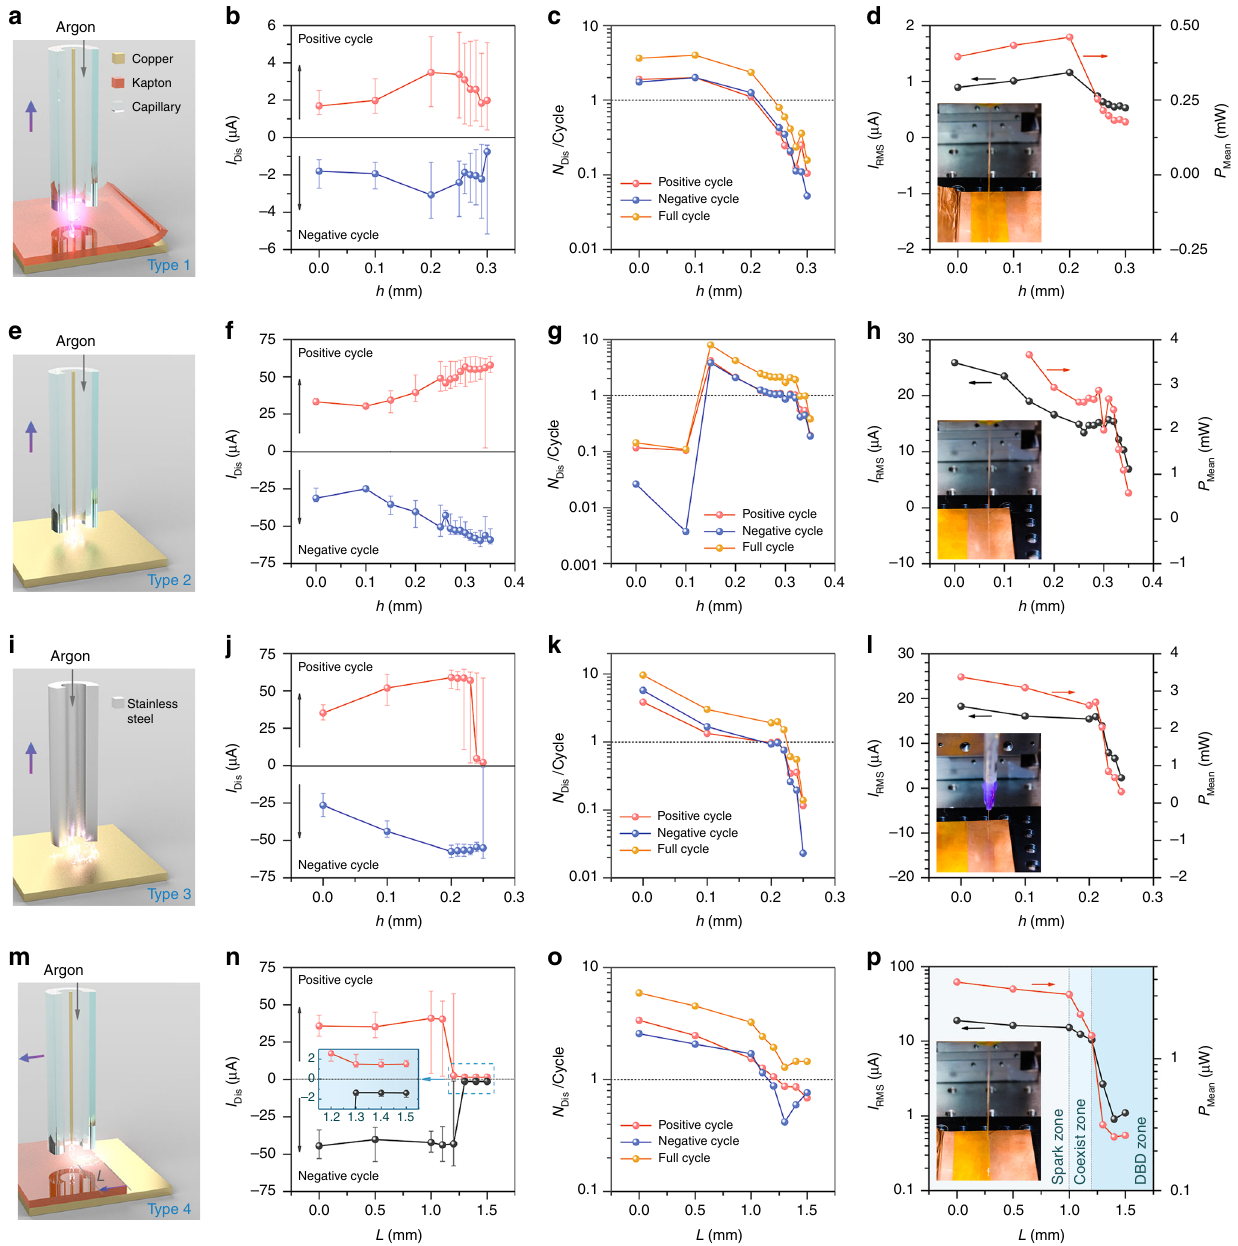
Fig. 4 Discharge characteristics change with distance between the electrodes in different discharges. a – d In dielectric barrier discharge (DBD) plasma (type 1), discharge current, time averaged number of discharge per cycle, effective value of current and mean power change (same characteristics as follows) when lifting the capillary with the copper wire electrode from the Kapton surface. In b , the symbol of ball means the median value and error bar indicates the range from 10% to 90% of the whole sampling data (similar as follows). e – h In microspark discharge (type 2), there is no dielectric fi lm between the two electrodes. At the beginning of lifting the copper wire, there is a continuous discharge path between the two electrodes which results in no pulsed discharge current detected ( g ) but high effective value of current just like short circuit current ( h ). i – l Another type of microspark discharge (type 3) with a stainless-steel capillary tube. m – p Holding the height of 0.20 mm, capillary moving horizontally from the border of copper and Kapton towards left which leads to the obvious changes of discharge mode and status from microspark to DBD plasma. p The current and power are both much higher in spark zone than those in DBD zone, and they decline sharply in the coexist